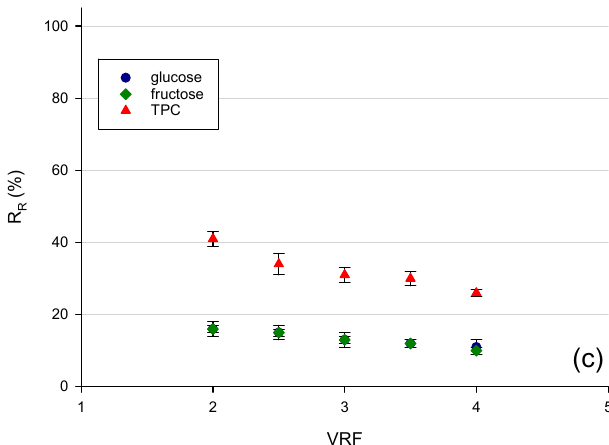
Figure 6. Recovery rate of total phenolic compounds, glucose, and fructose in the retentate stream during the batch concentration process with ( a ) TS40 ( b ) NP030 and ( c ) XN45 membranes.